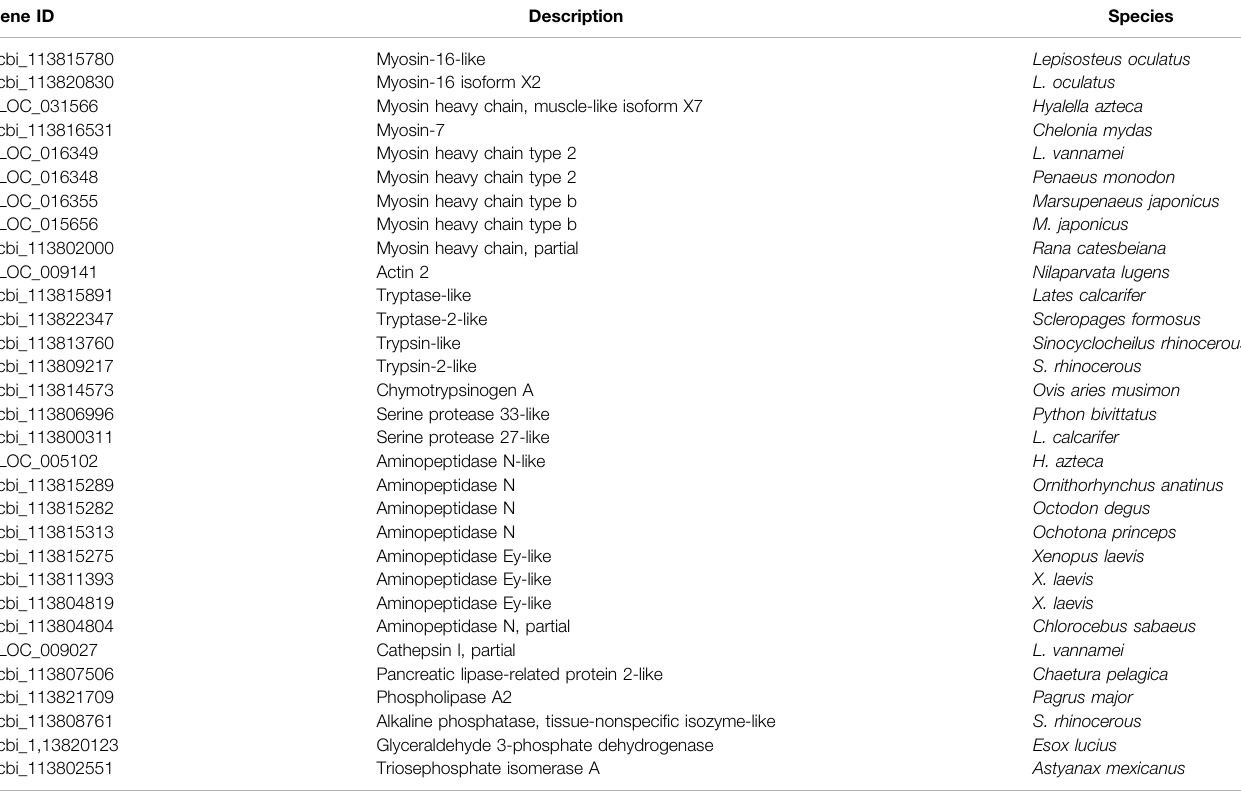
TABLE 4 | Myosin- and energy metabolism-related DEGs with high expression in VP AHPND -resistant Litopenaeus vannamei families. Gene